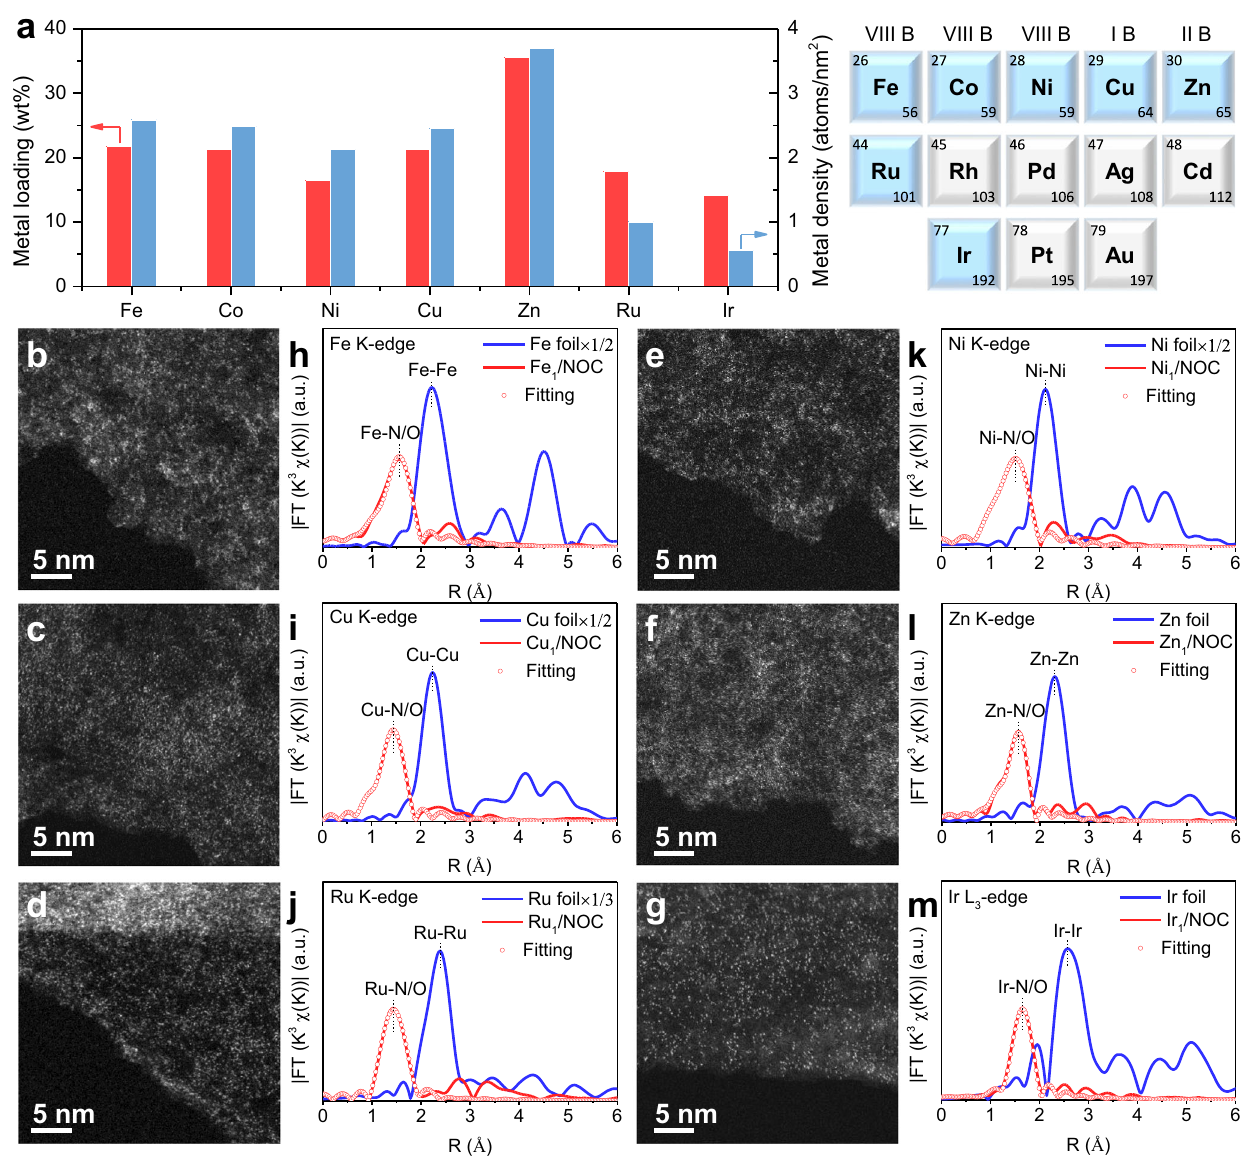
Fig.1|SynthesisandcharacterizationsofM-SACs.a MetalloadingsinM-SACsandschematicdiagramofpreparedM-SACs. b – g ACHAADF-STEMimagesand( h – m ) k 3 - weighted Fourier transform spectra of ( b , h ) Fe 1 /NOC, ( e , k ) Ni 1 /NOC, ( c , i ) Cu 1 /NOC, ( f , l ) Zn 1 /NOC, ( d , j ) Ru 1 /NOC, and ( g , m ) Ir 1